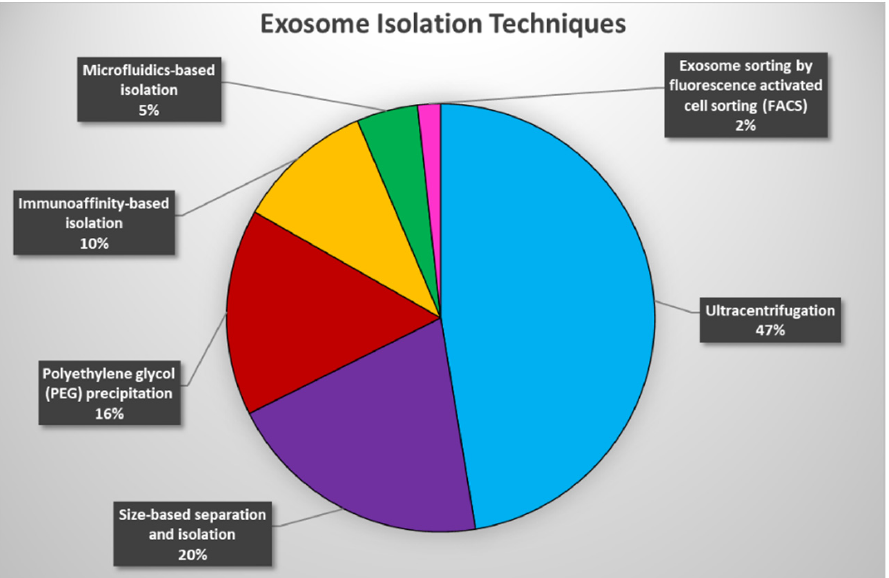
Figure 2. An estimate of the use of exosome isolation techniques over the past 10 years. Pie chart representation of the percentage utilization of each exosome isolation technique extracted from 173 publications spanning the years 2012–2022.